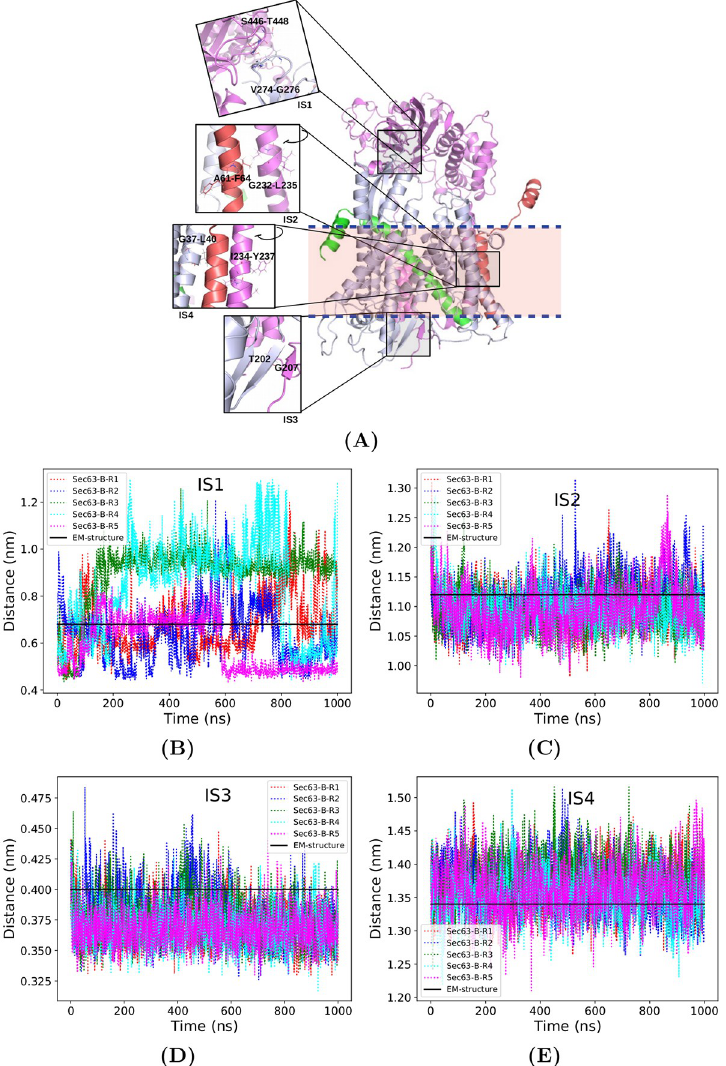
Fig 5. Interaction sites of Sec63 (mauve) and Sec61 complex. Sec61, Sbh1 and Sss1 are colored gray, red, and green, respectively. The light pink rectangle box with blue dashed borders represents the lipid bilayer. (A) Magnified views of the interaction sites. The evolution of the contact distances at interaction sites along with simulation time (B) interaction site 1 (IS1—V274-G276:Sec61 and S446-T448:Sec63), (C) interaction site 2 (IS2—A61-F63:Sbh1 and G232-L235:Sec63), (D) interaction site 3 (IS3—T202:Sec61 and G207:Sec63) and (E) interaction site 4 (IS4—G37-L40: Sec61 and I234-Y237:Sec63) during five independent MD simulations (Ri, i = replica number). The black horizontal line denotes the respective value in the cryo-EM